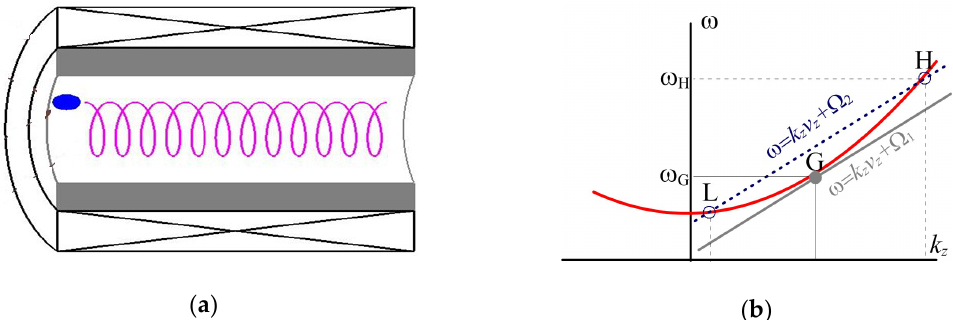
Figure 4. ( a ) The cross section of a cylindrical waveguide in which an electron bunch moves along helical trajectories; ( b ) dispersion characteristic for the cases of the electron velocity is close to the group velocity of the radiated wave (“grazing”, G), and for the two waves at low (L) and at high (H) frequencies generation regime.